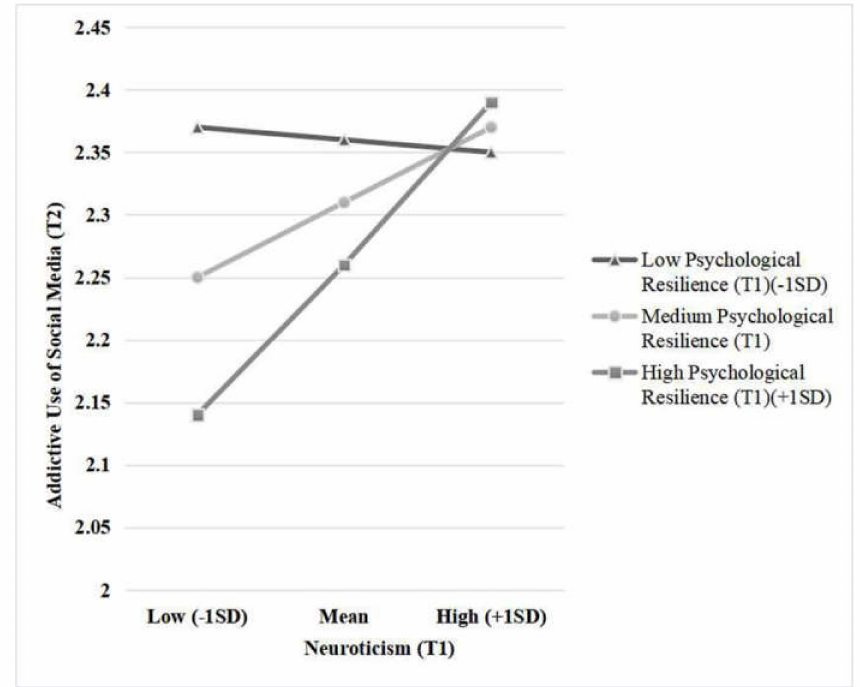
Figure 3. Simple slope test of the interaction between neuroticism (T1) and psychological resilience (T1) on the addictive use of social media